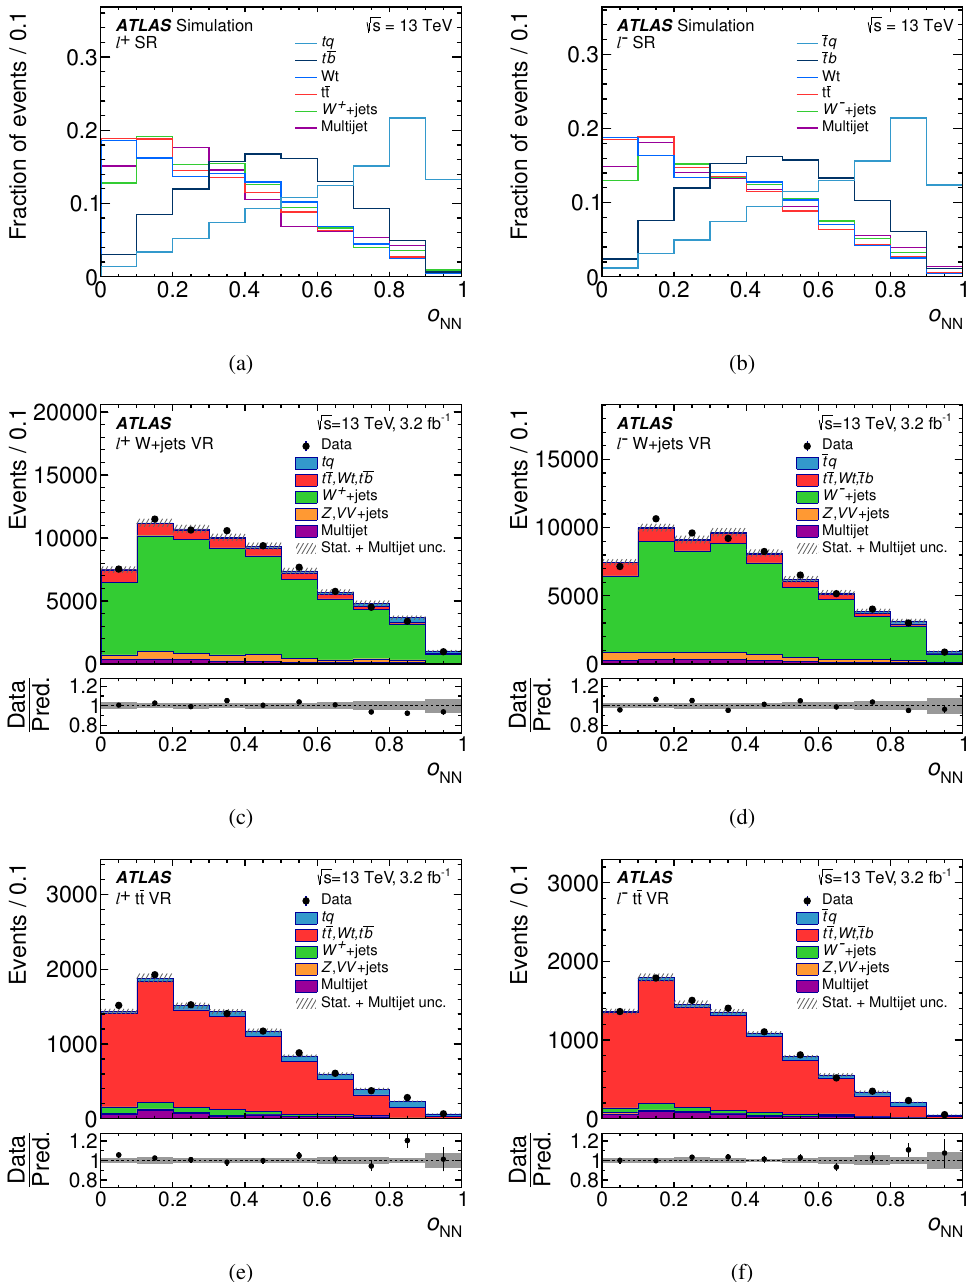
Figure 3 . Distributions of the NN discriminant O NN (left) for the ‘ + channel and (right) for the ‘ (cid:0) channel. (a)-(b): signal and background distributions normalised to unit area. (c)-(f): observed distributions in the W + jets VR and the t ¯ t VR compared to the model obtained from simulated events. The simulated distributions are normalised to match the number of observed events as described in the main text. The hatched and grey error bands represent the uncertainty in the number of multijet events and the uncertainty due to the size of the MC samples. The ratio of observed to predicted (Pred.) number of events in each bin is shown in the lower